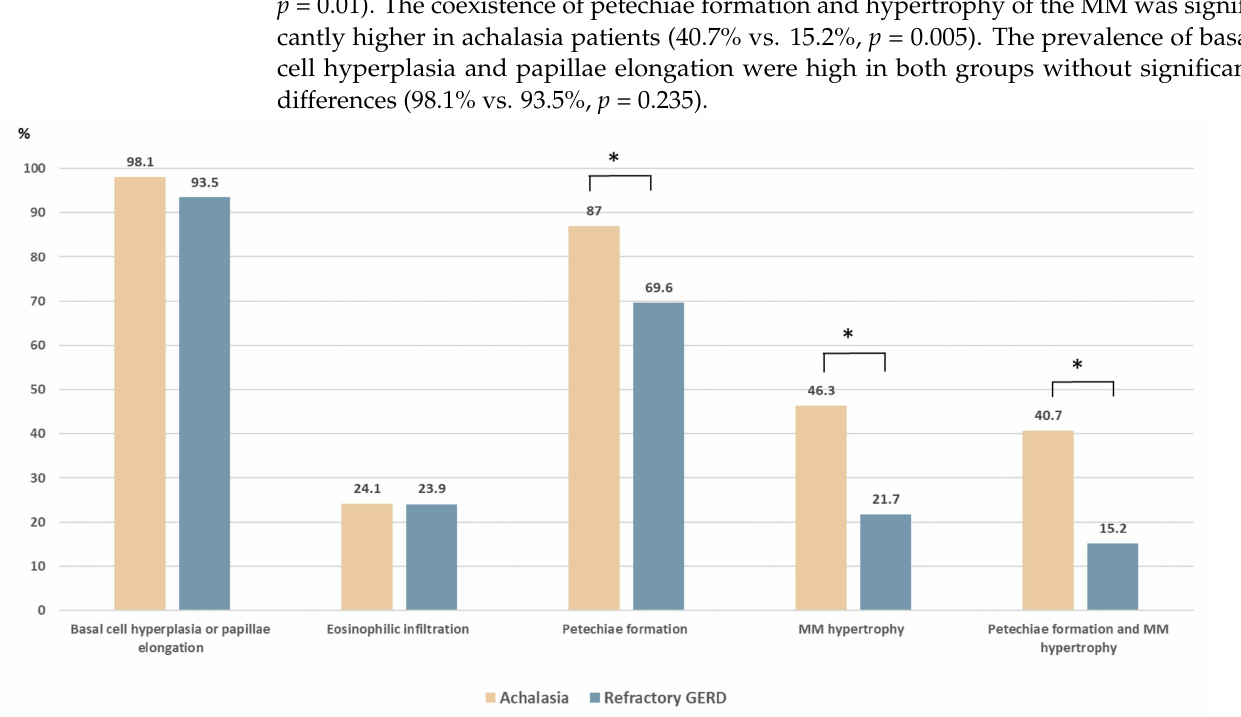
Figure 2. Histopathologic comparison between patients with achalasia and with refractory gastroesophageal reflux disease (GERD). Compared with the refractory GERD group, patients with achalasia had a higher prevalence of hypertrophy of the muscularis mucosae (46.3% vs. 21.7%, p = 0.01) and petechiae formation (87.0% vs. 69.6%, p = 0.033). The coexistence of petechiae formation and hypertrophy of the muscularis mucosae was significantly higher in patients with achalasia (40.7% vs. 15.2%, p = 0.005). * p <